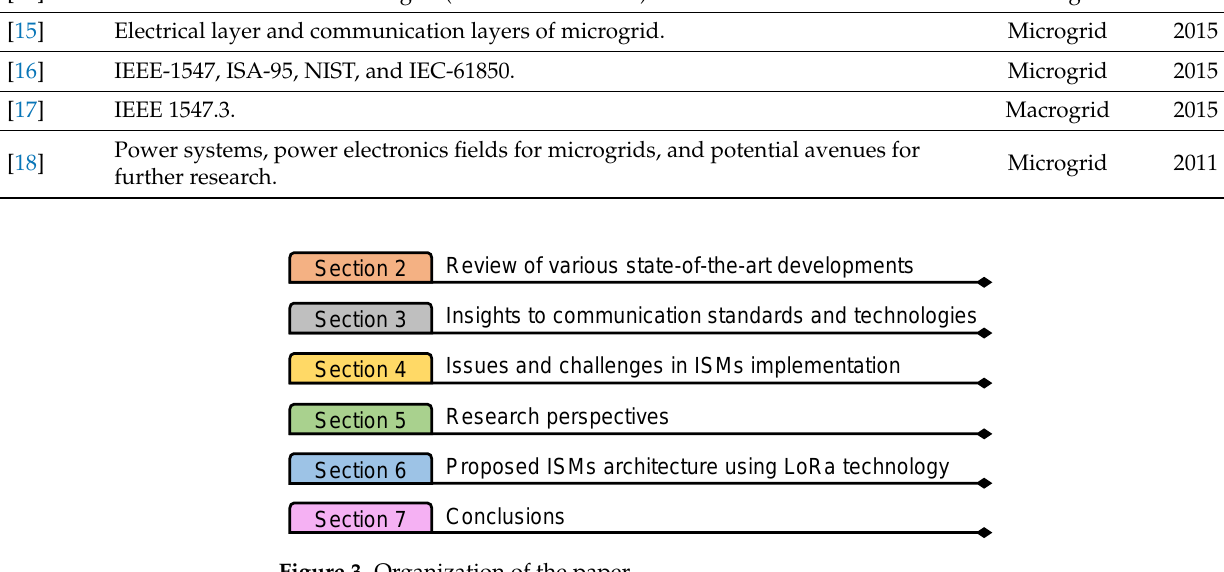
Figure 3. Organization of the paper.